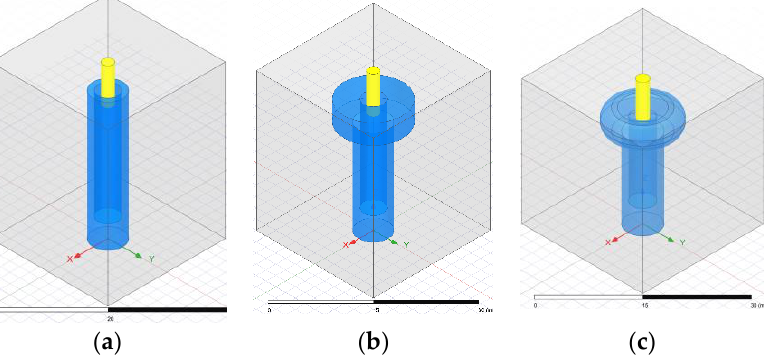
Figure 2. Schematic diagram of ( a ) water-pipe-type coaxial resonant ( b ) standard-disc coaxial resonant ( c ) donut capacitor-loaded coaxial resonant.